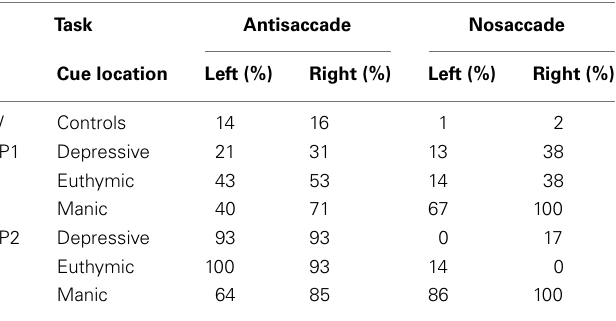
Table 2 | Saccadic inhibition error rates as a function of saccadic task (Antisaccade vs. Nosaccade), cue visual hemifield (Cue left vs. right), and illness phase (Depressive, Manic, Euthymic) for each patient (P1, P2) and for